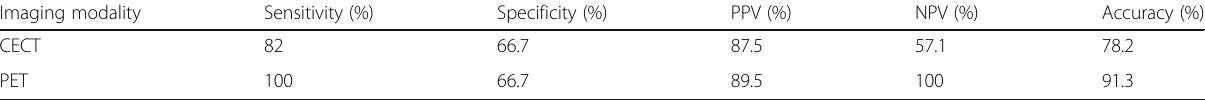
Table 3 Comparison of the statistical analysis of CECT and PET of the hepatic lesions managed by TACE Imaging